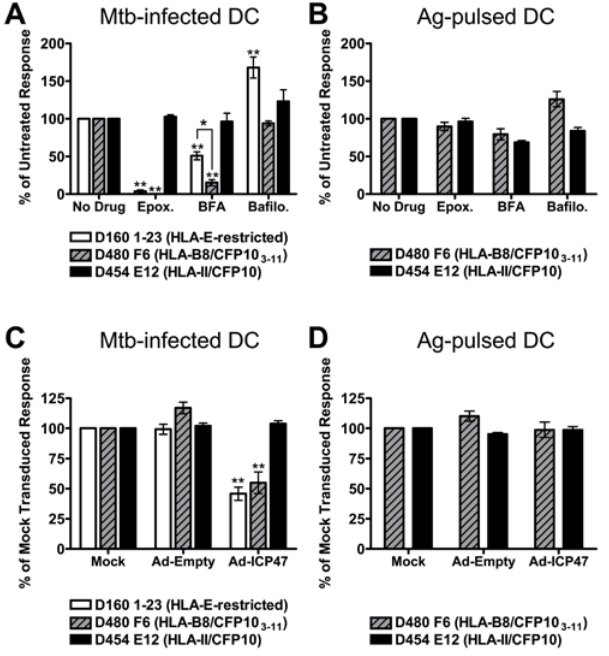
Figure 1. Mtb antigens are processed by the cytosolic pathway. (A,B) Human monocyte-derived DC were treated with epoxomicin, BFA, or bafilomycin for one hour before infection with Mtb H37Rv-eGFP (A) or addition of CFP10 and CFP10 3–11 (B). After 15–16 hours in the presence of the inhibitor, DC were harvested, fixed, washed extensively, and used as APC in an IFN- c ELISPOT assay where T cell clones are effectors. DC were added to an excess of T cells so that antigen was the limiting factor (see Materials and Methods). The mean number of spots produced by each clone was: D160 1-23 (228.4 6 39.3 to Mtb–infected DC, 19.6 6 6 to uninfected DC), D480 F6 (623.5 6 73.7 to Mtb–infected DC, 6.7 6 2.5 to uninfected DC), D454 E12 (453 6 52.4 to Mtb–infected DC, 13 6 4.4 to uninfected DC). Data have been normalized to the untreated control, and each bar reflects the mean 6 SEM of at least three experiments per clone (*p , 0.05, **p , 0.01 using two-tailed Student’s t test compared to untreated controls, except where indicated). (C,D) DC were transduced with either empty vector or adenoviral ICP47 using Lipofectamine 2000. After 6–26 hours, DC were washed and infected with H37Rv-eGFP (C) or pulsed with antigen (D). Following overnight incubation, T cell clones were added and IFN- c production was assessed by intracellular cytokine staining. The mean percentage of IFN- c + clones was: D160 1-23 (8.2 6 1.1 to Mtb–infected DC, 1.1 6 0.2 to uninfected DC), D480 F6 (46.4 6 3.9 to Mtb–infected DC, 1.5 6 0.4 to uninfected